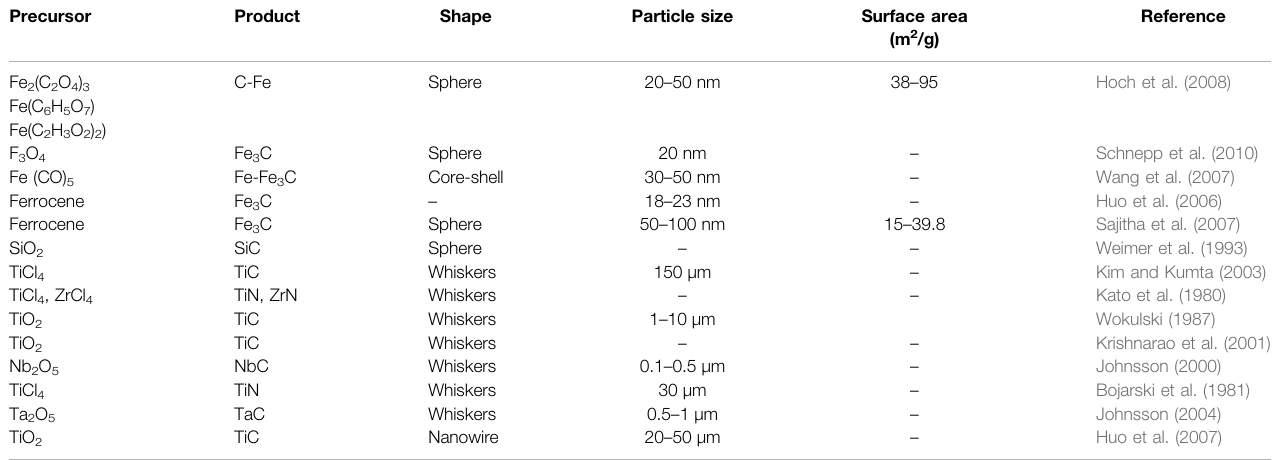
TABLE 3 | Properties of metal carbide and nitride materials through carbothermic reduction approach. Precursor